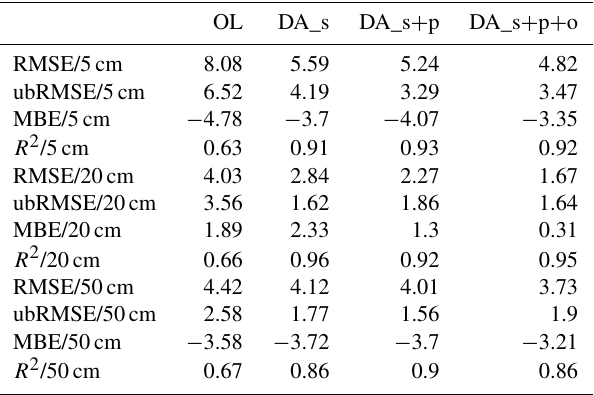
Table 2. Statistical evaluation measures for the four different sim- ulation and assimilation scenarios, always compared to measure-